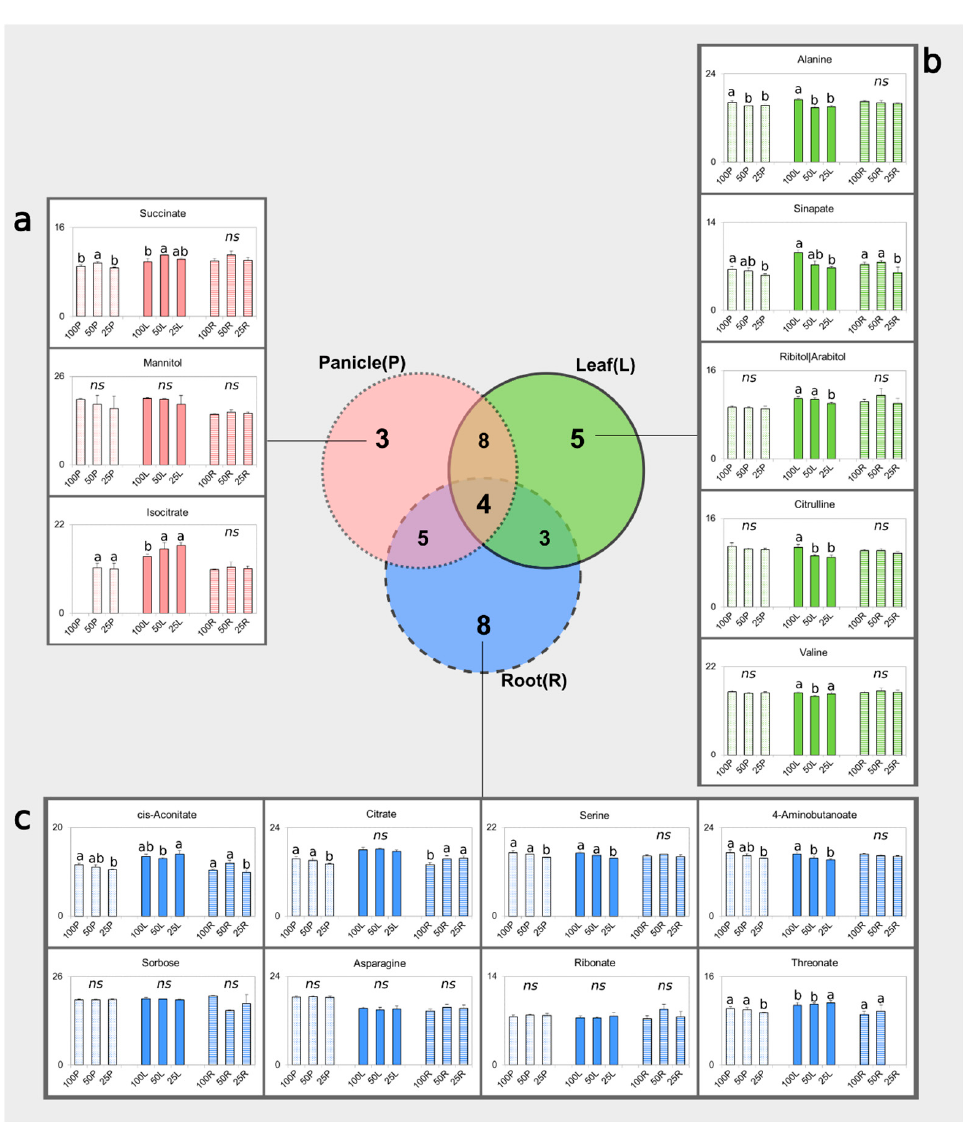
Figure 3. Comparison of water-deprivation-responsive metabolites identified in panicles (P), leaves (L) and roots (R) of S. viridis plants. For each plant organ, the metabolites of the components PC1 and PC2 were combined and compared, for a total of 36 metabolites. ANOVA significance for ( a ) panicle-specific, ( b ) leaf-specific and ( c ) root-specific metabolites. Different letters indicate signifi- cant differences ( p < 0.05) between the water treatments in the same plant organ. Asterisks indicate a significant effect of the water treatments in each plant organ ; ns = not significant.